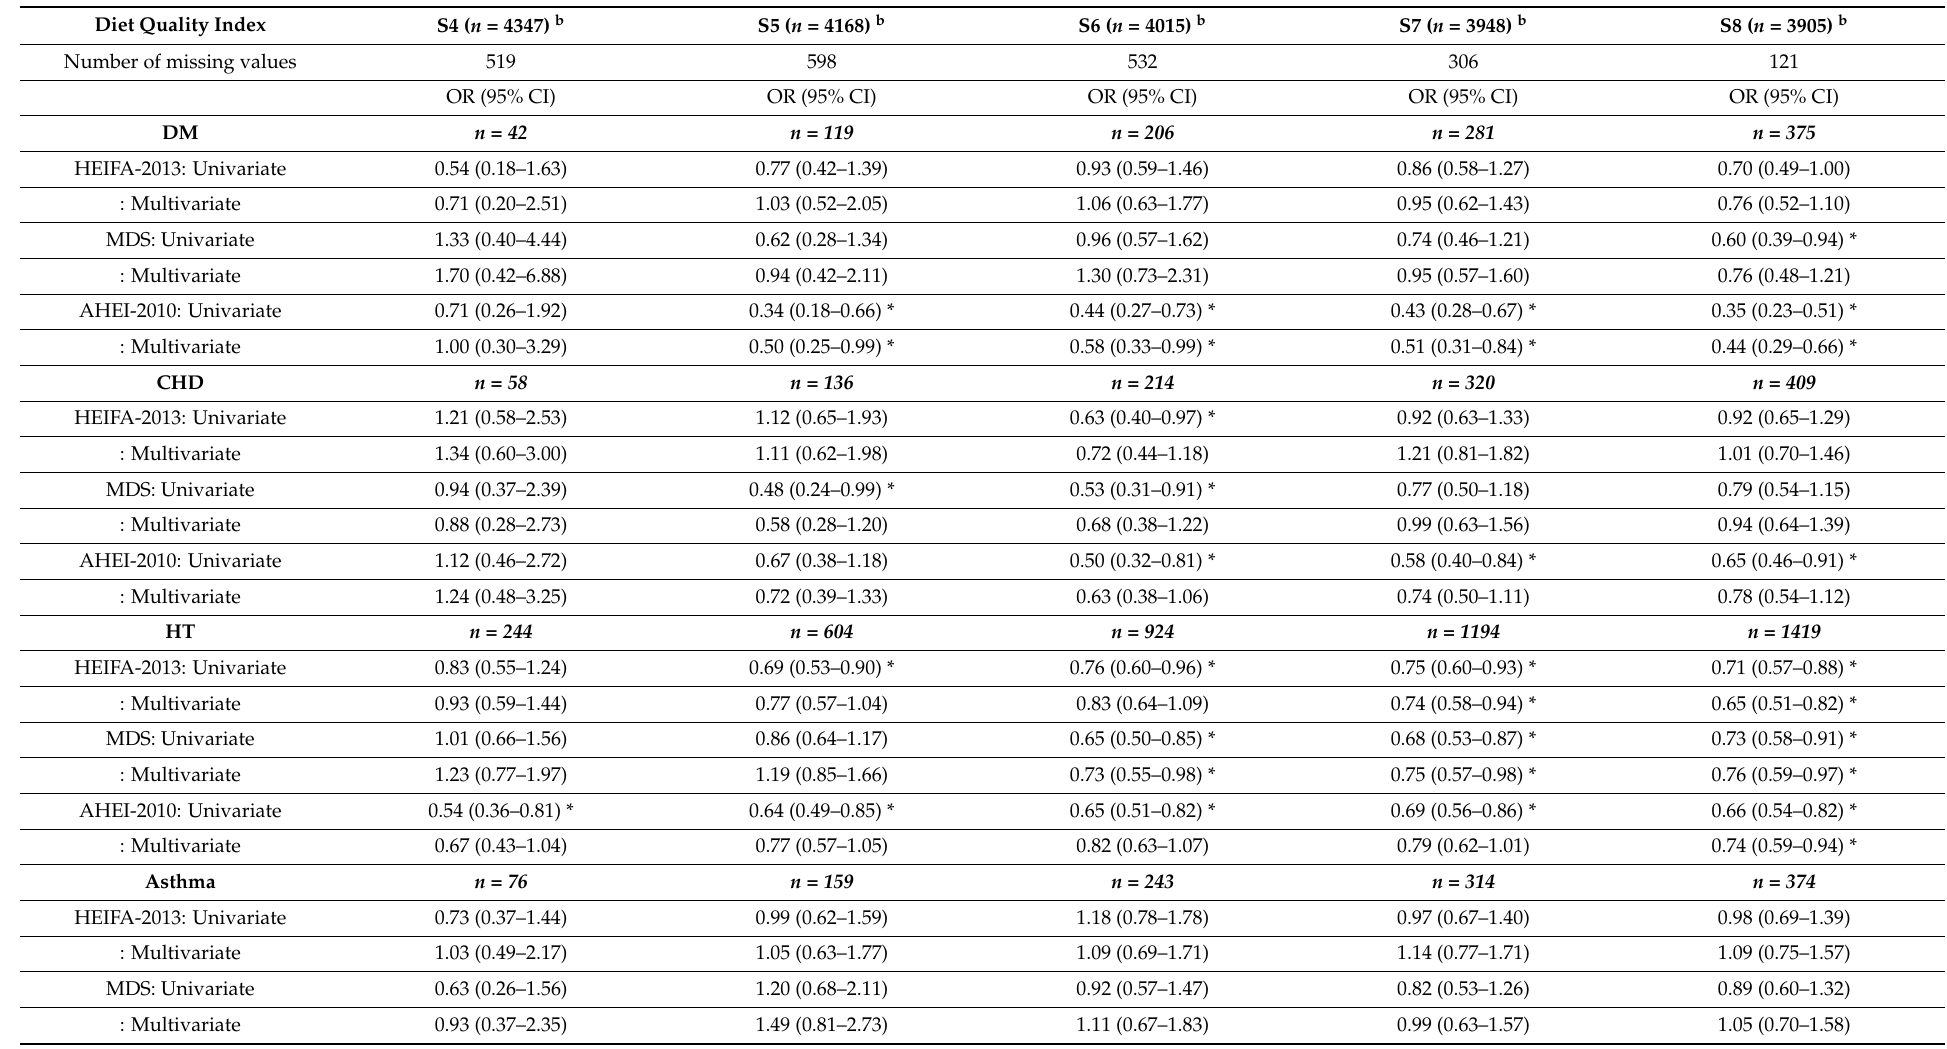
Table 2. Associations between diet quality indices and risk of common NCDs (including multimorbidity) among 1946–1951 ALSWH cohort women (from S4 to